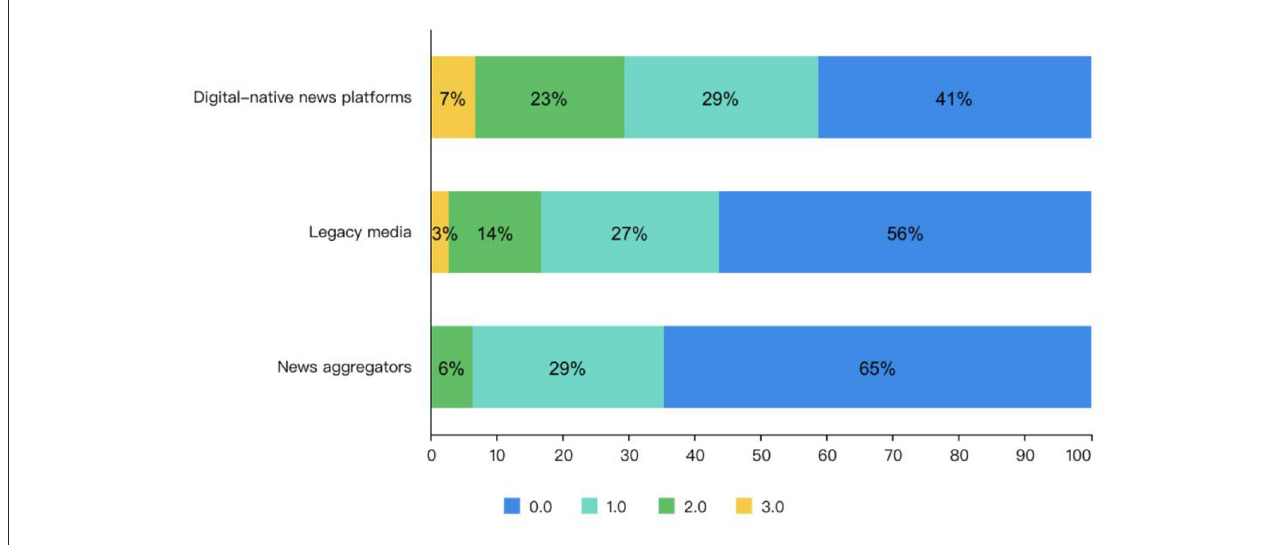
FIGURE5 The preprint frame adoption scores of the different media types.